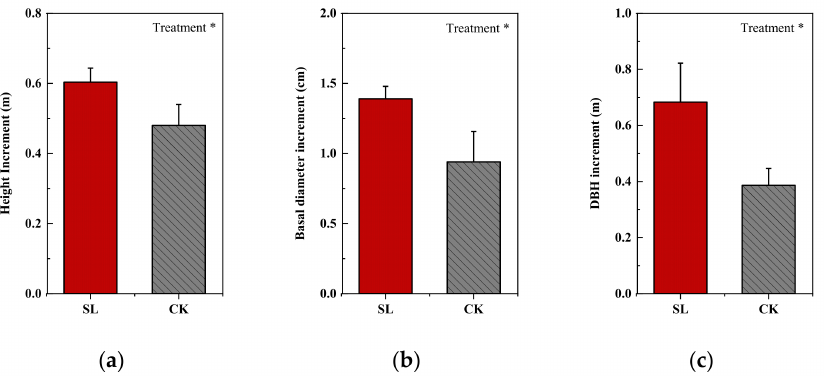
Figure 2. Effects of sewage sludge (SS) application on Mongolian pine growth. ( a ) Height increment (m), ( b ) Basal diameter increment (cm), and ( c ) DBH increment (cm) of the tree. SL, SS application treatment; CK, control treatment without SS application. All the values are mean ( ± SD) for each variable, measured in all three replications ( n = 3) within each treatment. * p <